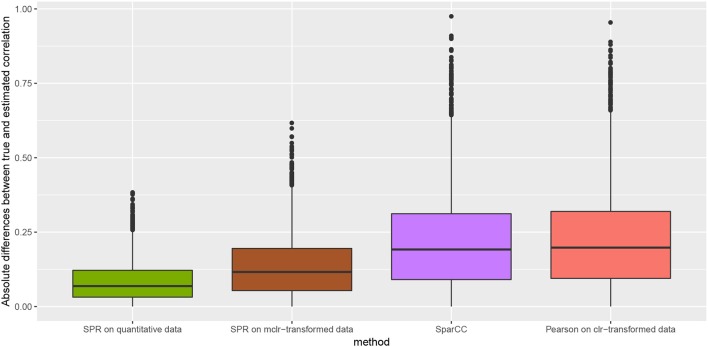
Absolute differences between true and estimated correlation coefficients, |σjk-σ^jk|, for four methods: SPR correlation estimation on quantitative data (green), SPR correlation estimation on mclrε-transformed compositional data (brown), SparCC estimation (Friedman and Alm, 2012) (purple), and Pearson sample correlation on clr-transformed data (red) [as used in SPIEC-EASI (Kurtz et al., 2015)].